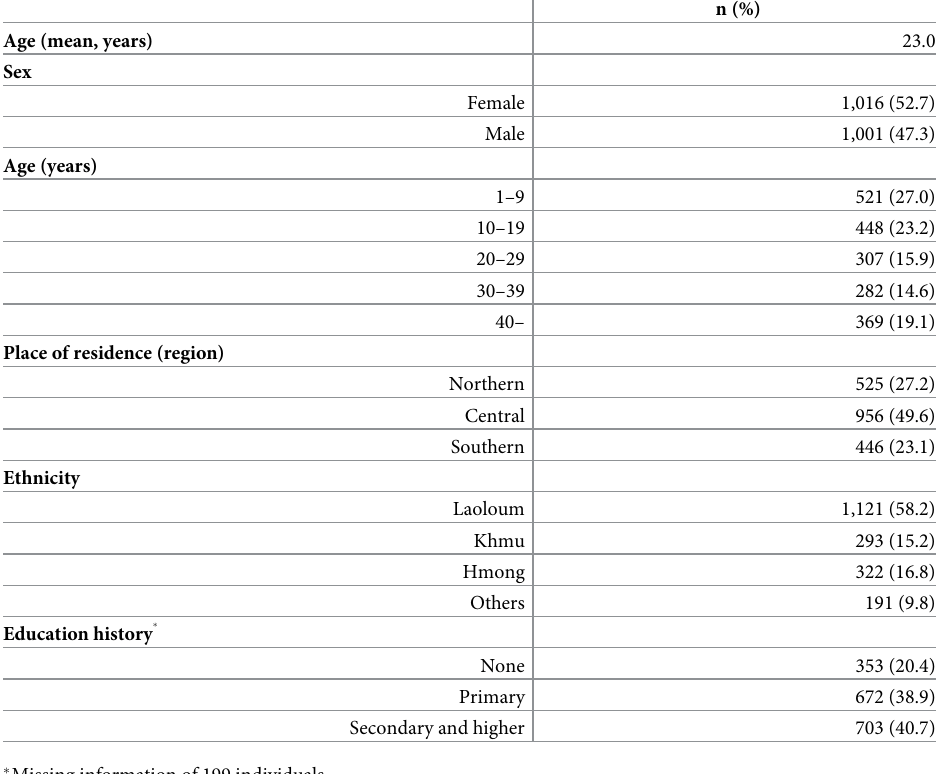
Table 1. Demographics of survey participants (N =